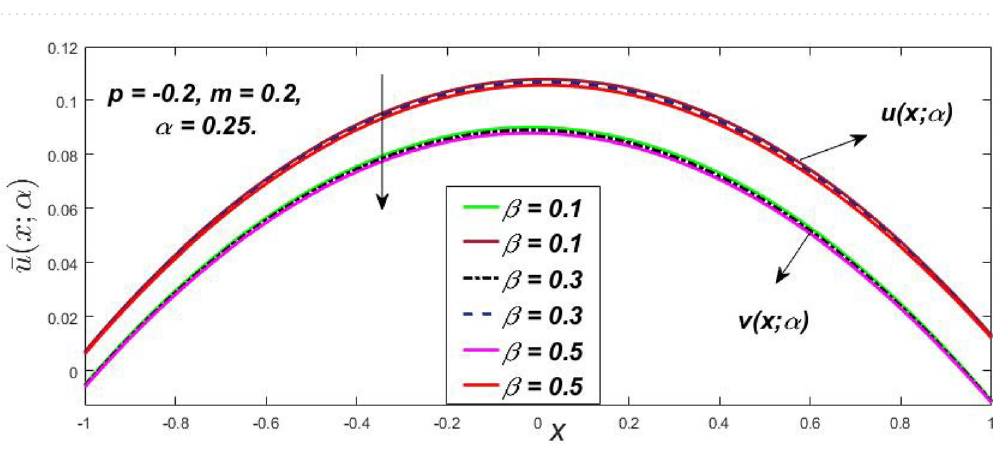
Figure 15. Fuzzy velocity profiles for the impact of β